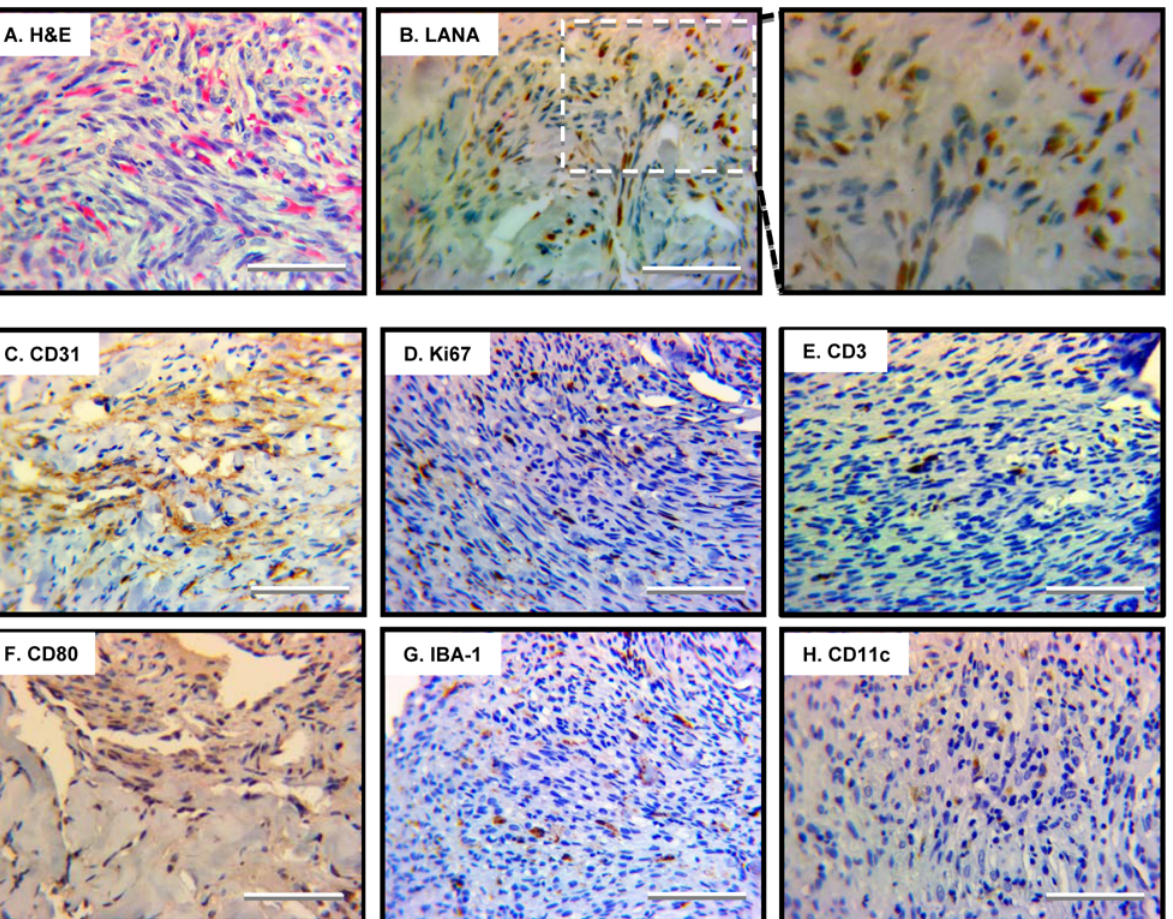
Fig 7. Angiogenic and inflammatory features of human Kaposi ’ s sarcoma. Human Kaposi ’ s sarcoma lesion was analyzed by H&E staining (A) and immunohistochemistry staining with antibodies against the latent nuclear antigen LANA (B), markers for endothelial cells CD31 (C), proliferating cells Ki67 (D), T cells CD3 (E), antigen-presenting cells CD80 (F), macrophage IBA-1 (G) and dendritic cells CD11c (H). Representative images were shown and scale bars denote 25 μ